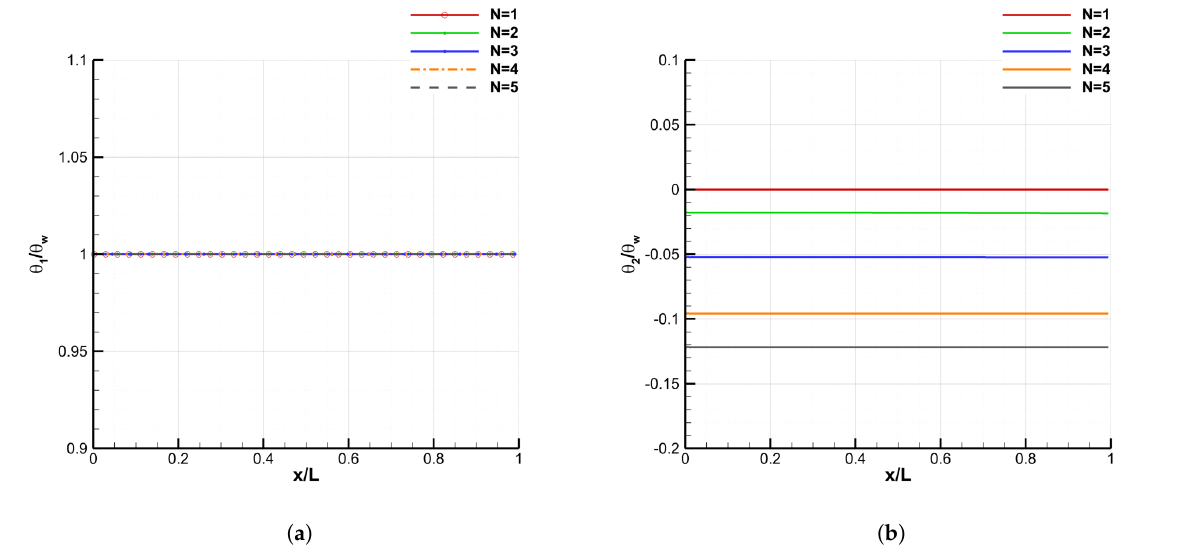
Figure 7. θ j for N = 1 to N = 5: ( a ) θ 1 , ( b ) θ 2 . Test case 1, N x = 256.